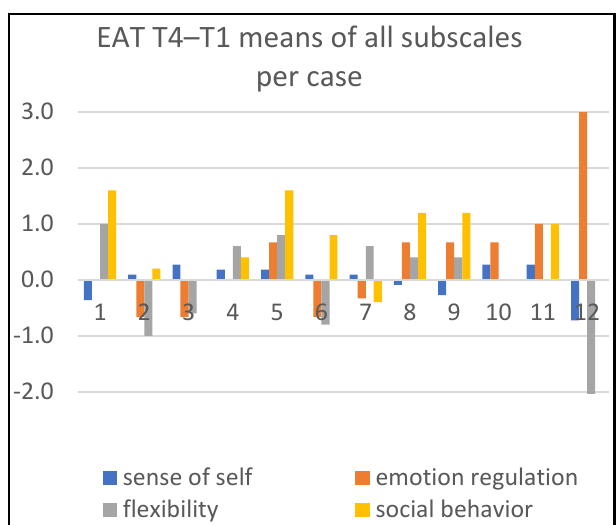
Figure 4. Means of all subscales per case, T3–T1.